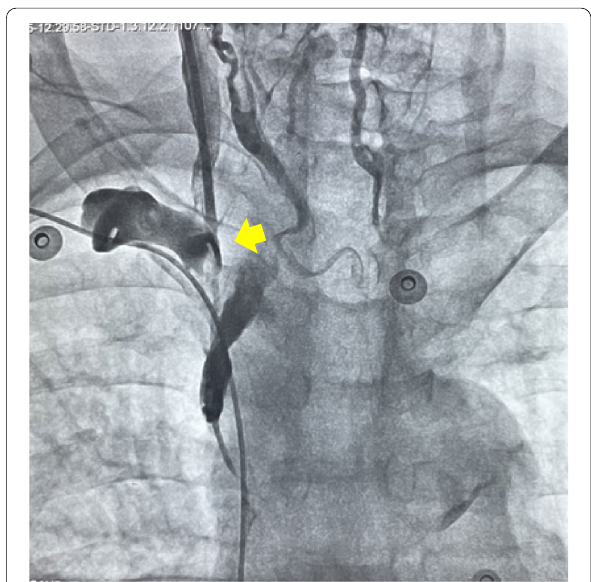
Fig. 2 Perforation of right IJV due to temporary pacing lead in a patient with stenosis of right subclavian and brachiocephalic vein after permanent